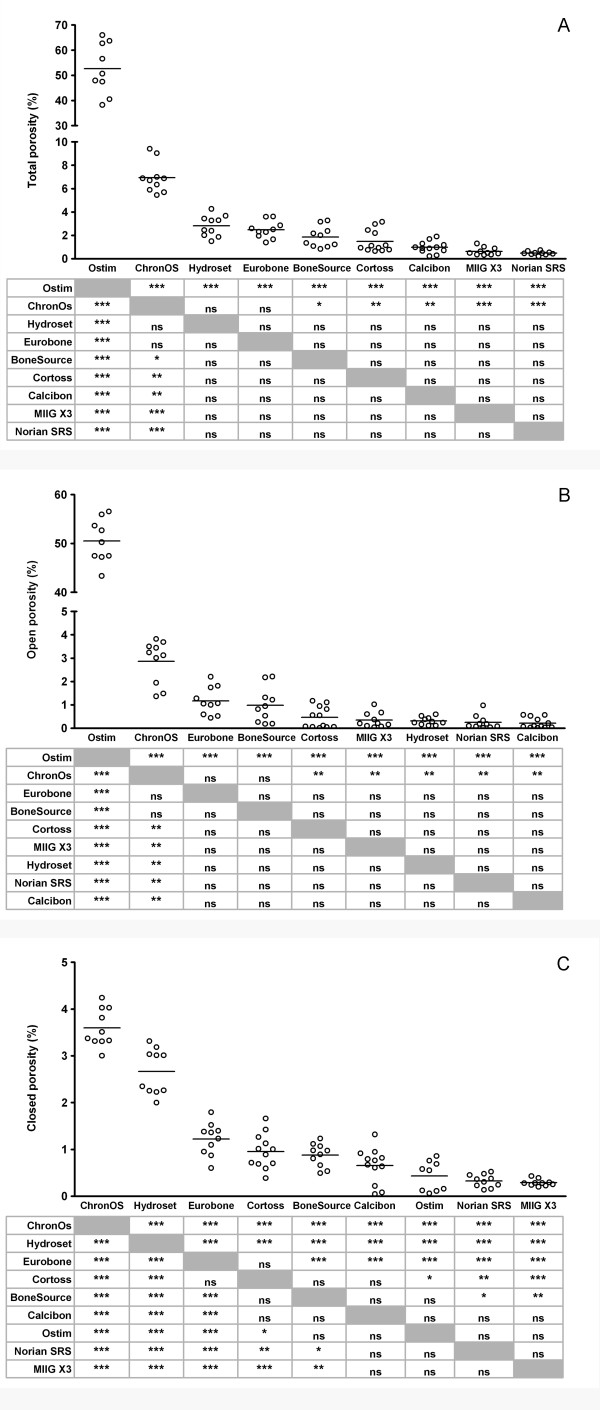
Porosity of bone substitutes Porosity of individual test samples was determined upon Micro-CT-scanning as described in the Materials and Methods. The total porosity (A), open porosity (B) and closed porosity (C) were determined. Each dot represents an individual test sample, and lines indicate the average value. The table below the figure shows the outcome of the pairwise comparisons (Student's T-test with Bonferroni correction). *, p < 0.05; **, p < 0.01; ***, p < 0.005; ns, not statistically significantly different. Grey boxes represent the self-self combinations, which could not be tested.